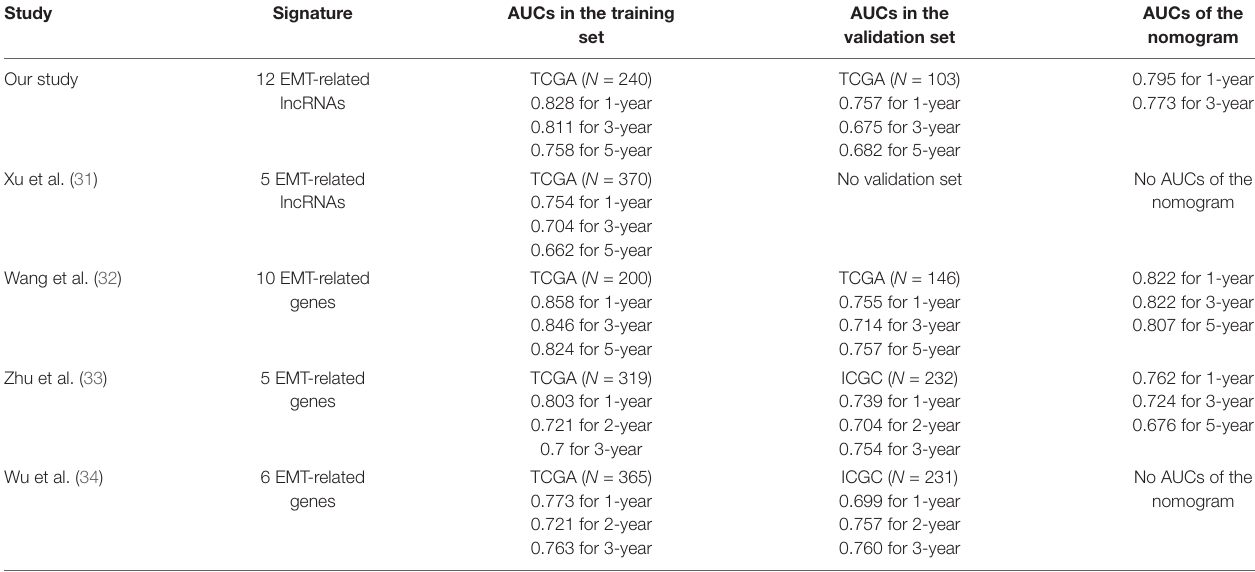
TABLE 4 | Comparison of the risk model and other